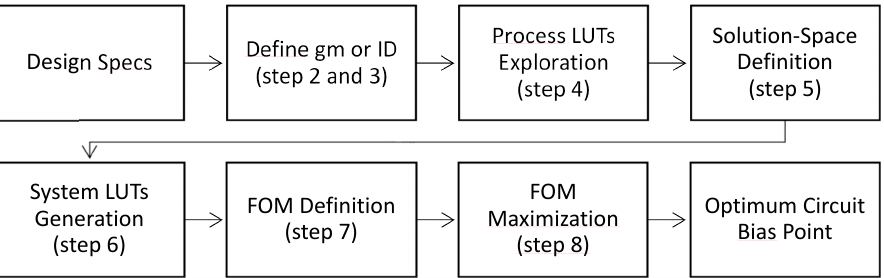
Figure 4. The design framework.